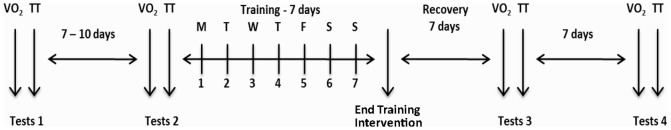
Sequence of training and testing followed by the cyclists in the experimental groups; control group subjects completed tests 2 and 4 only.VO2  =  Maximal incremental exercise test, TT  =  time trial.